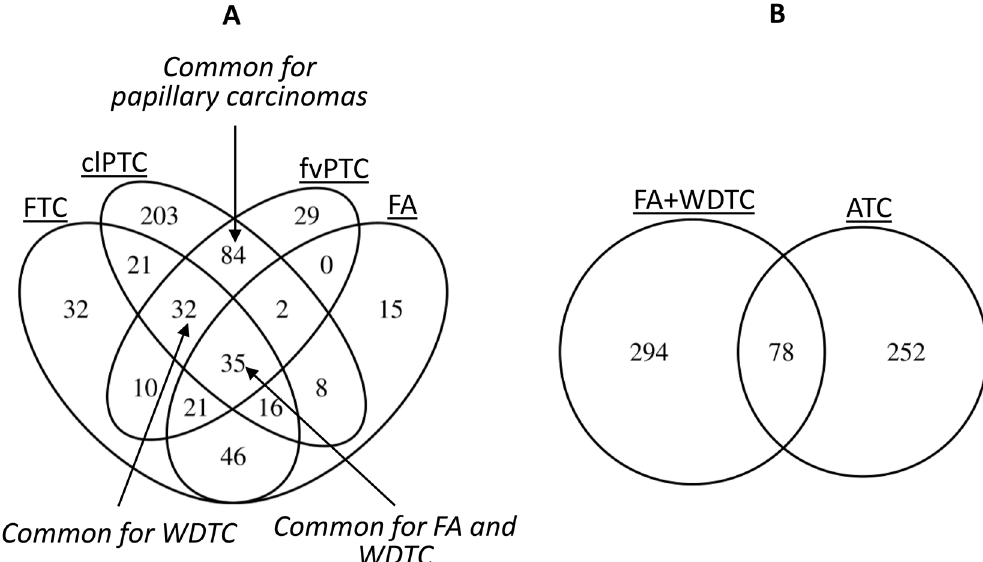
Figure 3. Intersection of lncRNA landscapes in thyroid neoplasms. ( A ) lncRNA landscapes in FA, FTC, fvPTC, and clPTC (based on the RNA-Seq PRJEB11591 dataset). ( B ) LncRNA landscapes in differentiated neoplasms (total list of lncRNAs differentially expressed in FA, FTC, fvPTC, and clPTC) and ATC.